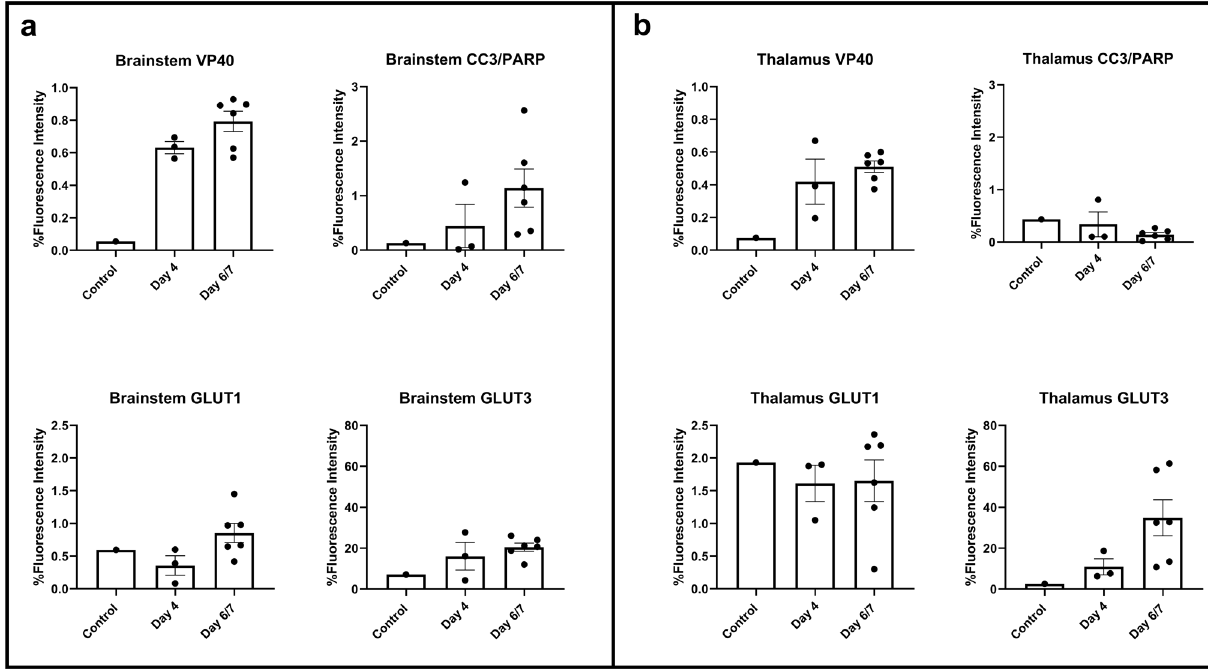
Fig. 5 Quanti fi cation of multiplex fl uorescence immunohistochemistry staining for viral antigen (VP40), apoptosis (CC3/PARP1) and glucose transporters (GLUT1 and GLUT3). a There is increased VP40, CC3/PARP1, GLUT1 and GLUT3 staining in the brainstem, more so on days 6 and 7 compared to day 4 post inoculation ( n = 10 animals). b There is increased VP40 and GLUT3 staining in the thalamus of infected animals, more so on days 6 and 7 compared to day 4 post inoculation ( n = 10 animals). Data are presented as mean values + / − SEM. Source data are provided as a Source Data fi